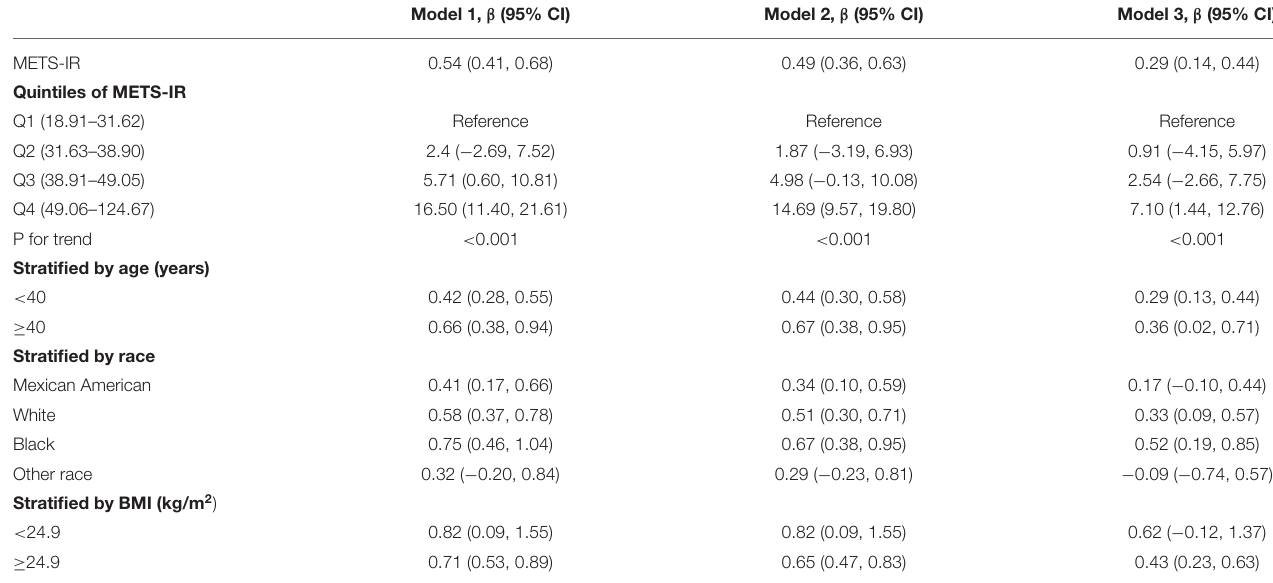
TABLE 2 | Association between METS-IR and serum ferritin